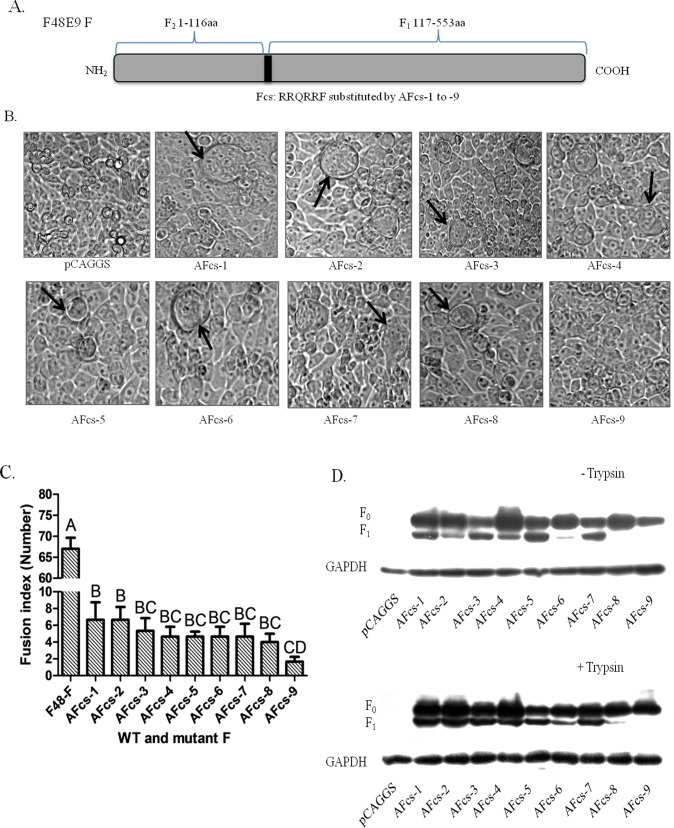
Syncytium formation induced by avirulent Fcs and HN in BHK-21 cells.(A) Schematic of virulent Fcs substituted with AFcs-1 to AFcs-9 in the F48E9 F backbone. (B) Syncytium formation induced by co-transfection with pCAG-Fcs mutants and pCAG-HN of F48E9 (0.4 μg of F and 0.4 μg of HN). Syncytia are indicated by black arrows. (C) Average syncytia size was determined in the presence of trypsin. Data are the average of syncytia numbers in three independent experiments where statistical significance is designated with capital letters and different letters indicate significant differences (P<0.01). (D) Proteolytic cleavage of the F protein with Fcs variants. BHK-21 cells were co-transfected with 0.4 μg of pCAG-F with different Fcs and 0.4 μg of pCAG-HN. The F protein was analyzed via Western blot at 48 h post-transfection. GAPDH protein expression is shown as a control.